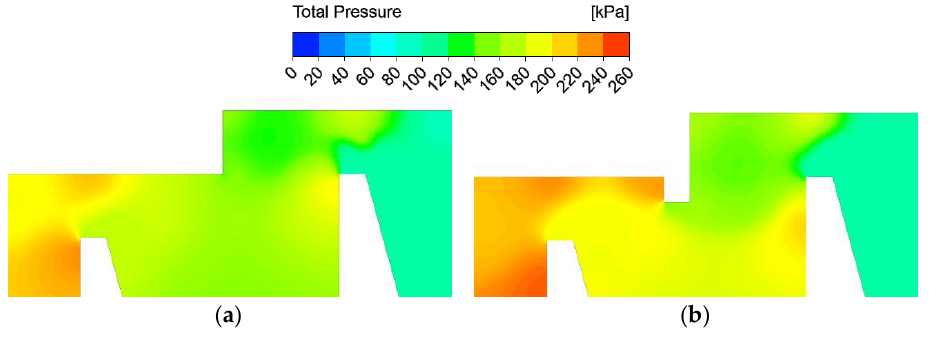
Figure 10. Static pressure plots for conventional seal and ribbed seal (PR = 2.5, S/H = 1.0, t/K = 0.1, β = 90°). ( a ) Conventional seal. ( b ) Ribbed seal.